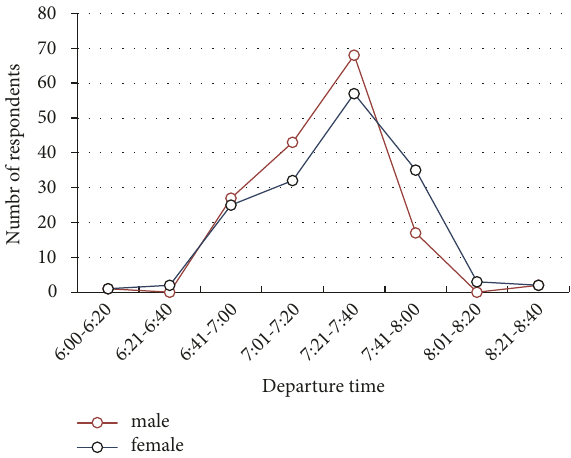
Figure 2: Cumulative value distribution of departure time decision.